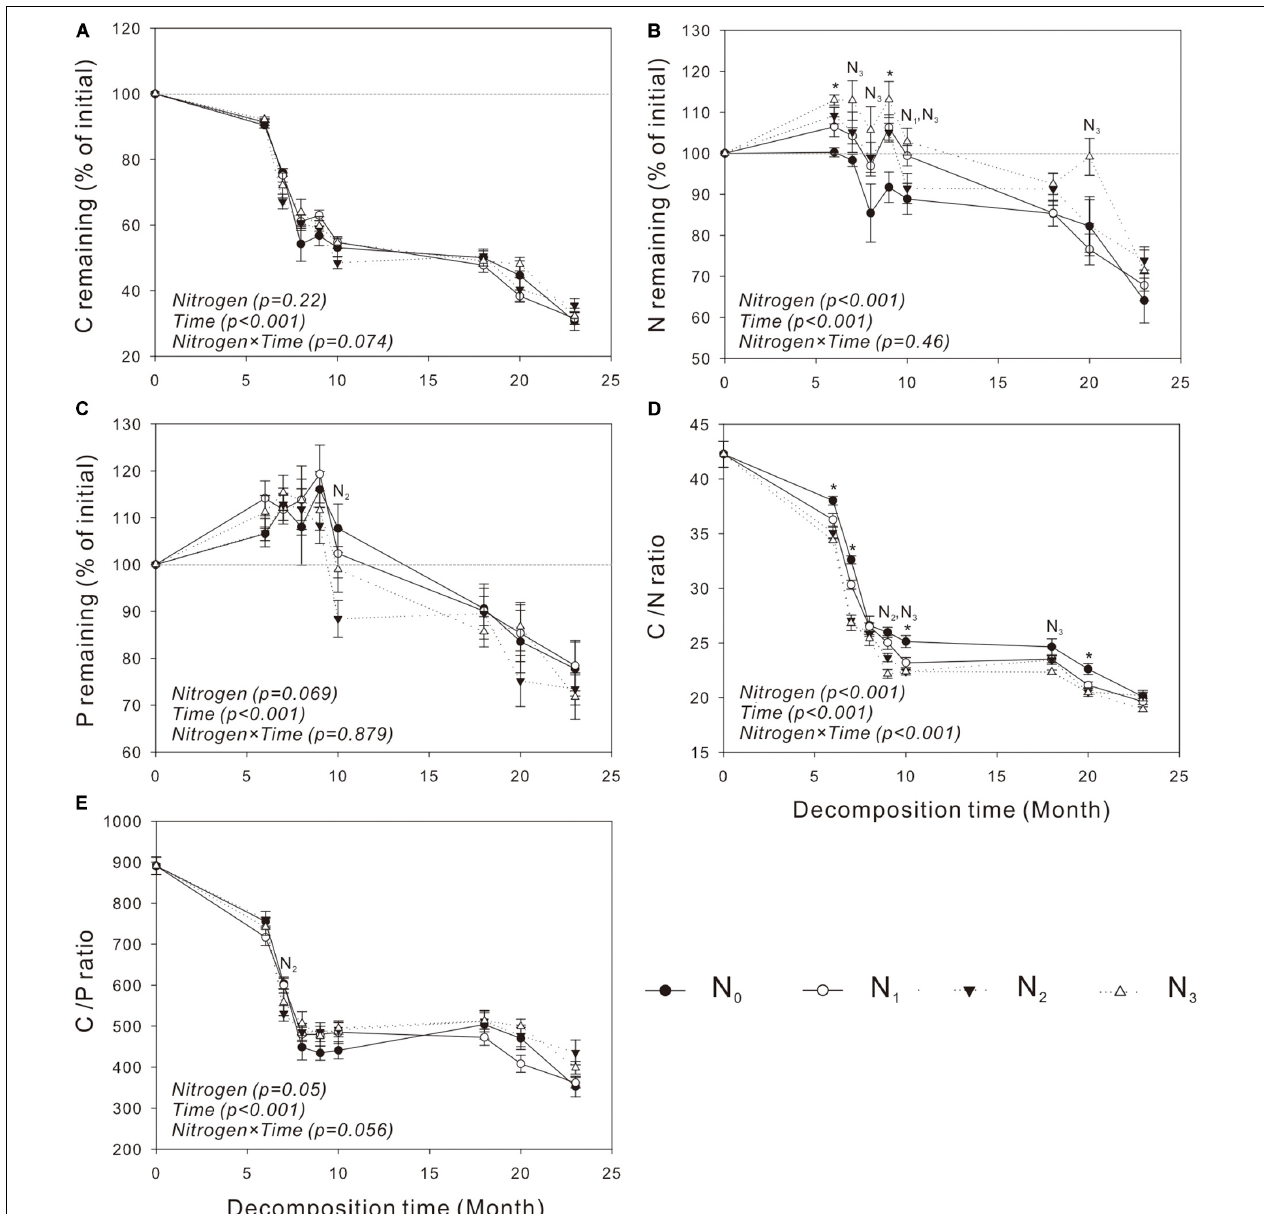
FIGURE 2 | Dynamics of the remaining C, N, and P and the C/N and C/P ratios in Vitex negundo leaf litter (A–E) at different N addition levels during the whole experimental period. Text in italics indicates the effects of N and time, as well as their combined effects, based on the two-way ANOVA. N 1 , N 2 , and N 3 at each decomposition time indicate that the difference between the specified N treatments and the control (CK) was significant ( P < 0.05). The symbol * means that all N treatments were significantly different from the control. Error bars represent the standard deviations of the means ( n = 3). N 0 , control; N 1 , low N; N 2 , moderate N; and N 3 , high